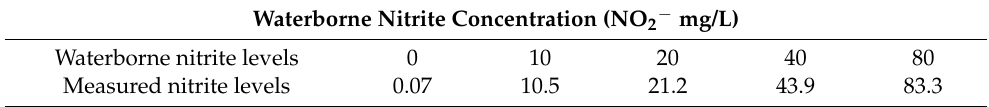
Table 3. Analyzed waterborne nitrite concentration (NO 2 − mg/L) from each